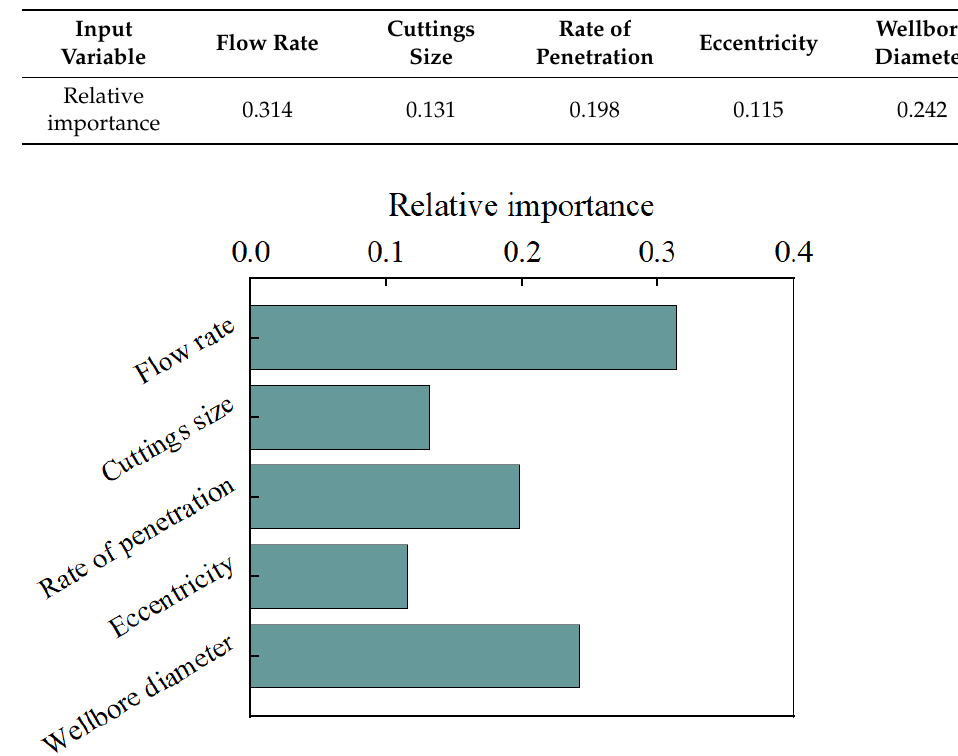
Figure 9. The relative importance of the input variable. The predicted results of the ANN model are also compared with the dimensionless model predicted by Song et al. (2017) [19], as shown in Equation (5). The AAPE of the dimensionless cuttings bed height model is 9.77%, as shown in Figure 10. In other words, the ANN model performs better than the dimensionless cuttings bed height model.